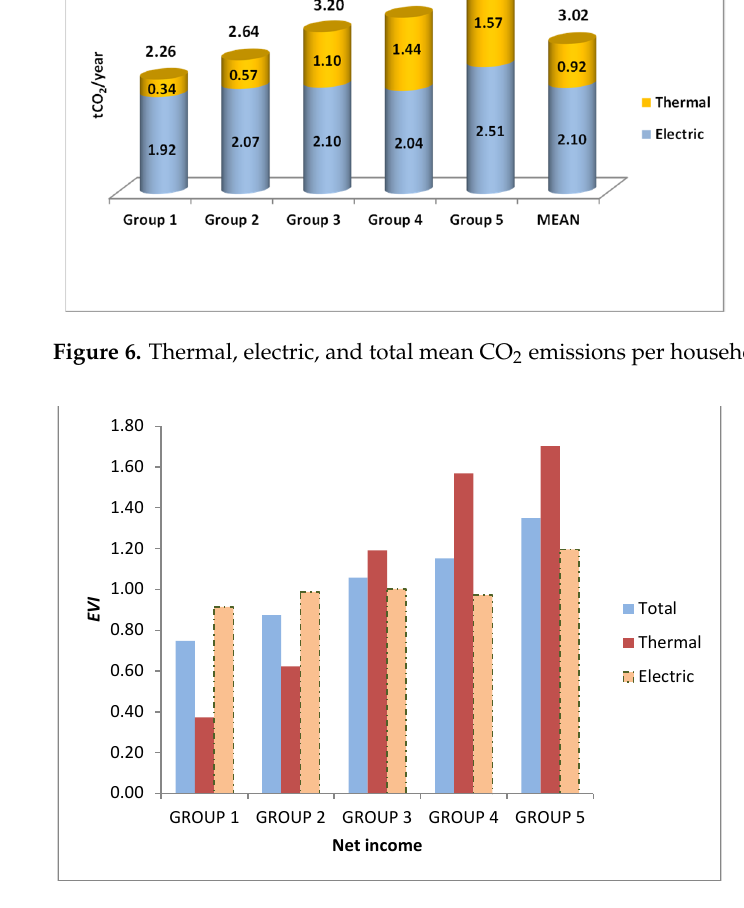
Figure 7. Variation of the EVI index for CO 2 emissions per household by group. Total emissions increased as NMW increased. Except for cities with income below 1.5 NMW, the others produced emissions above the mean. The cities with the most emissions, those with incomes above 2.5 NMW, produced emissions 35% above the mean. At the other extreme were cities with incomes below 1 NMW. In them, the emissions were 25% lower than the